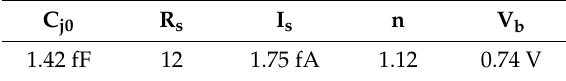
Table 1. Parameters of the AP1 anti-parallel Schottky